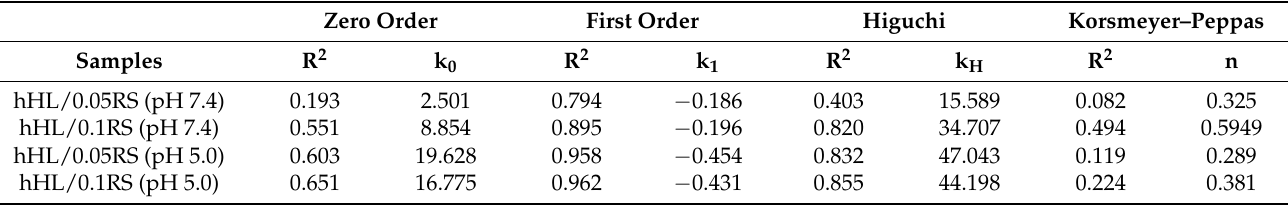
Table 2. The release kinetics of RS-loaded